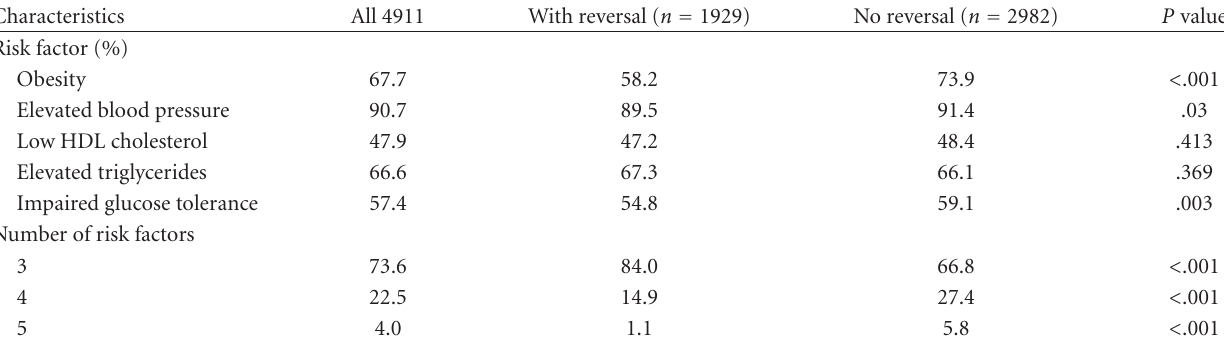
Table 2: Comparisons of basal characteristics between the entire subjects and those with and without reversal of clustering of CVD risk factors.